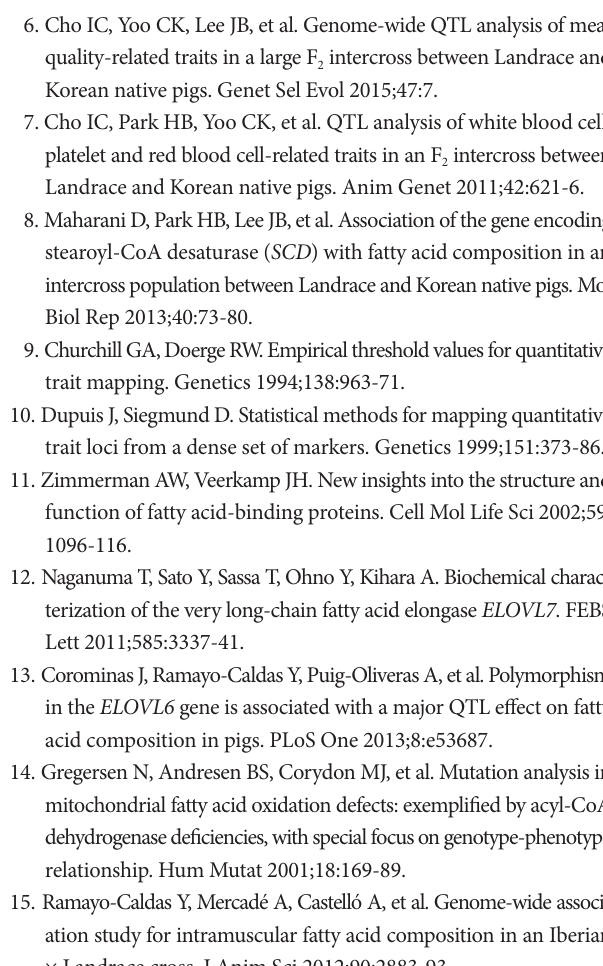
Figure 1. Quantitative trait loci (QTL) profiles for fatty acid composition traits on SSC12. The y-axis represents the F-value testing the hypothesis of a single QTL under additive model on a given position on the chromosome. The marker map with genetic distance between microsatellite (MS) markers in Kosambi cM is given on the x-axis. The horizontal line indicates the 5% genome-wide significant